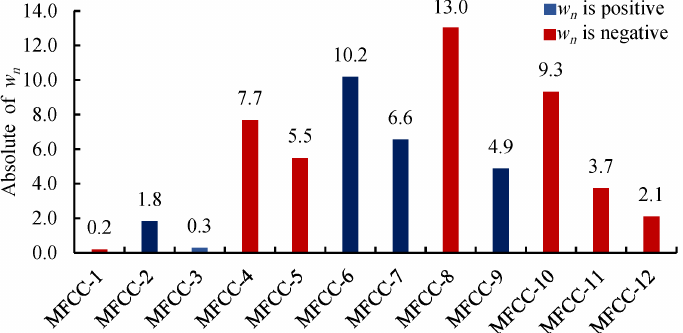
Figure 7. Absolute value of the coefficient w n corresponding to MFCC-n in AIEFPC. The blue bars indicate w n is positive while red indicates w n is negative.